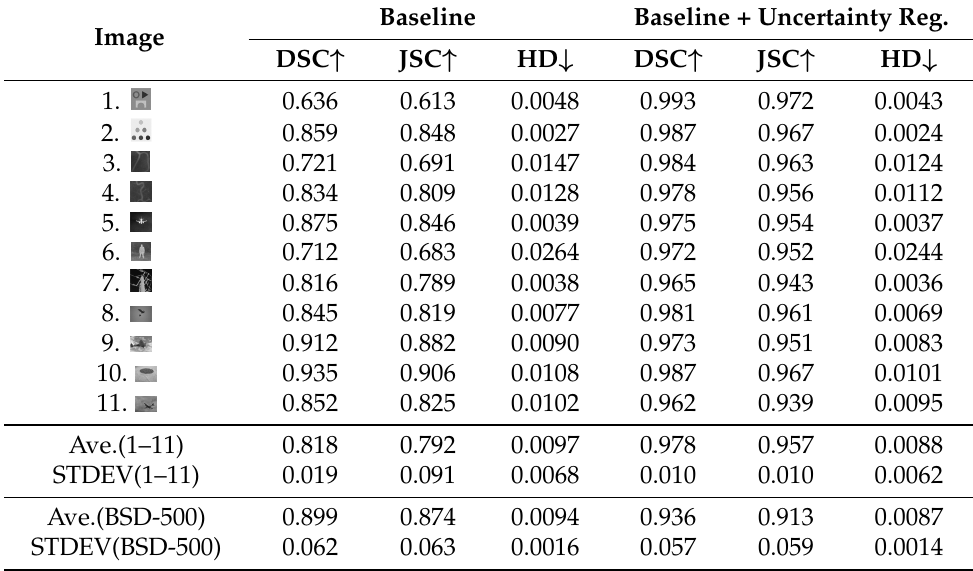
Table 3. The ablation experiments of uncertainty regularization on the 11 images and BSD-500 [41]. Baseline Baseline + Uncertainty Image